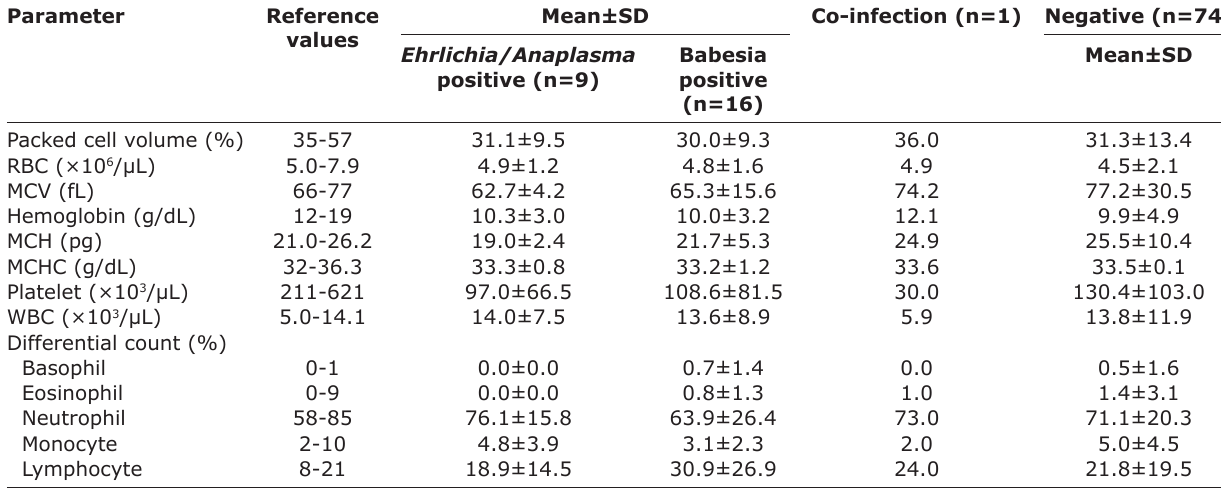
Table-2: Complete blood count analysis results of dogs tested for Ehrlichia/Anaplasma and Babesia spp. in Cebu, Philippines (n=100).